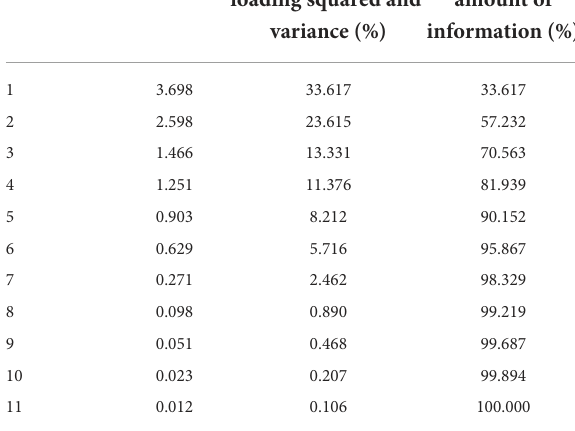
TABLE 1 Total explained